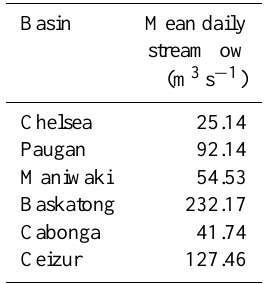
Table 1. Mean daily streamflow for the six sub-catchments of the Gatineau River basin, from 1 January 1950 to 4 November 2004.